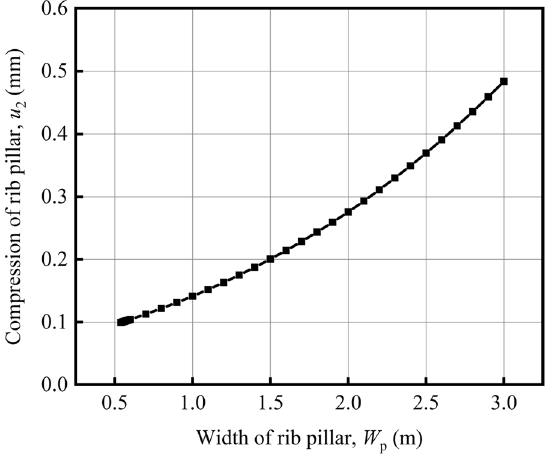
Fig. 12 The maximum compression of the rib pillar under the